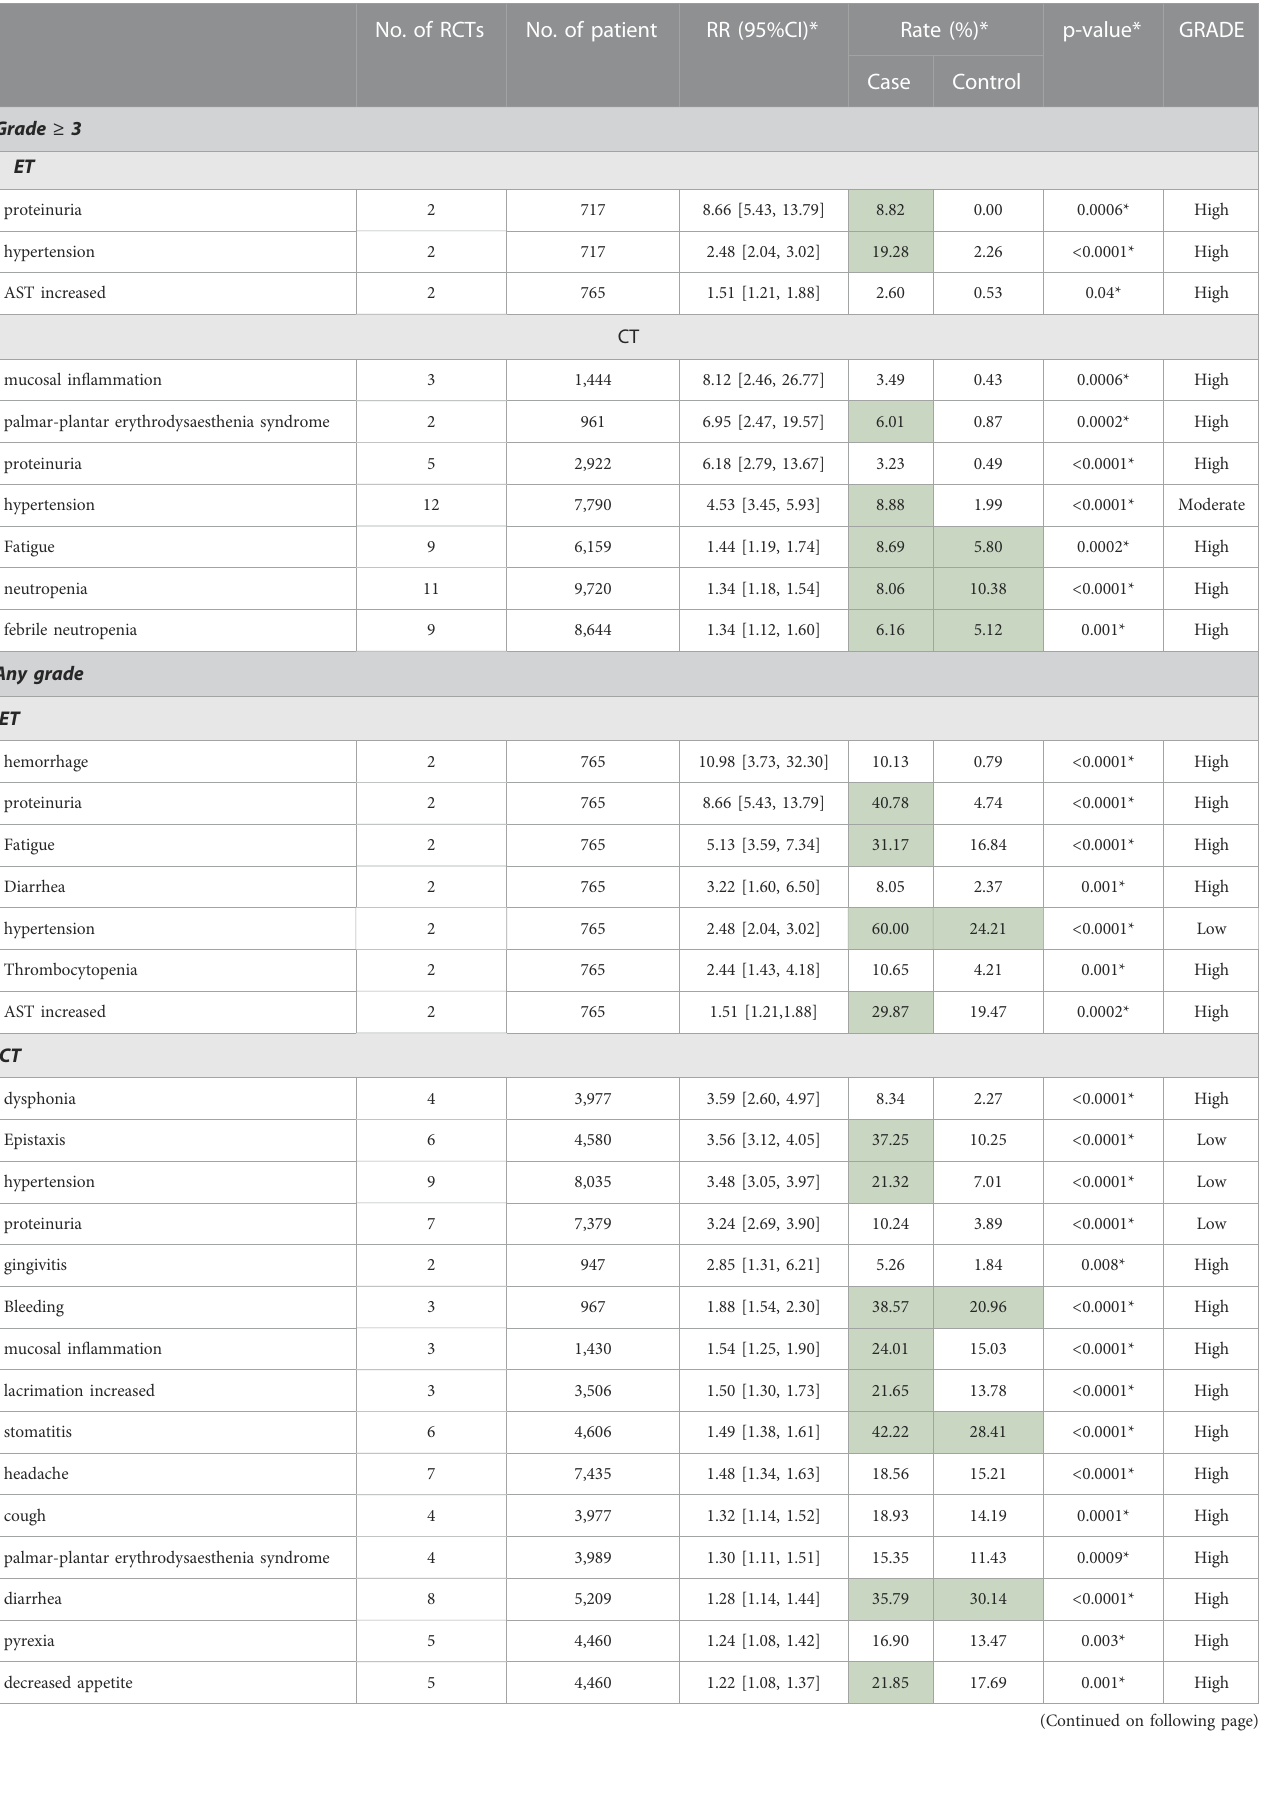
TABLE 6 Subgroup outcome of ET or CT.